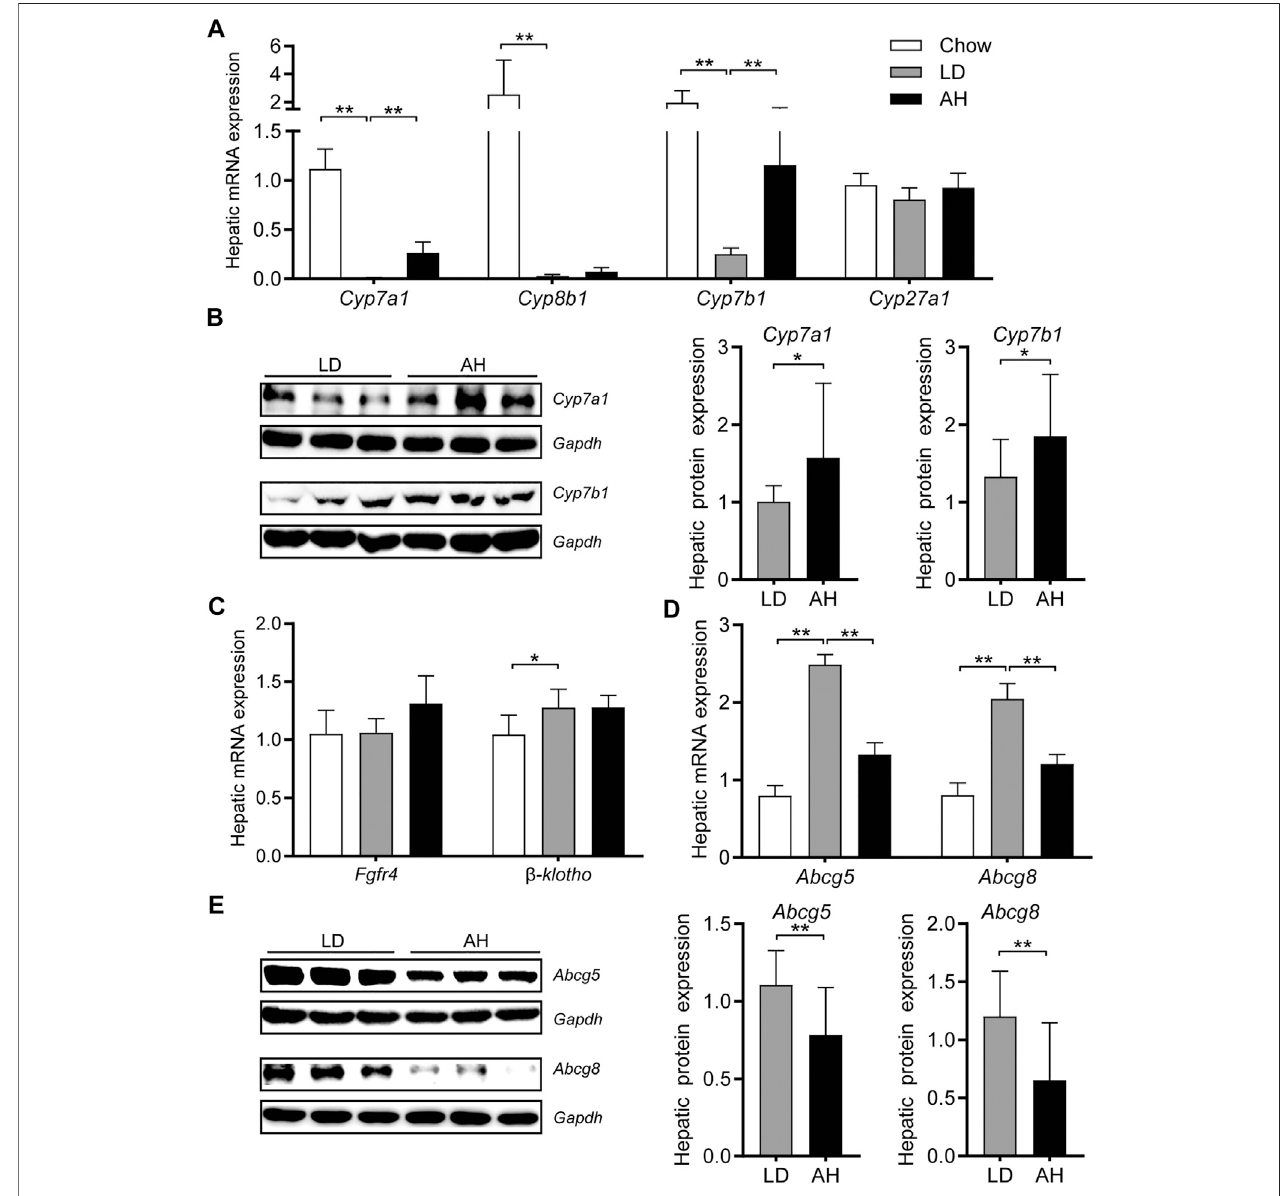
FIGURE 5 | Expression of the genes involved in cholesterol transport and bile-acid synthesis in the liver. (A) mRNA expression of Cyp7a1 , Cyp8b1 , Cyp7b1 , and Cyp27a1 ( n (cid:2) 8). (B) Proteinexpression(leftpanel) andquanti fi cation(middleand rightpanel)of Cyp7a1 and Cyp7b1 ( n (cid:2) 6). (C) mRNAexpressionof Fgfr4 and β -klotho ( n (cid:2) 8). (D) mRNA expressionof Abcg5 and Abcg8 ( n (cid:2) 8). (E) Proteinexpression (leftpanel) andquanti fi cation (middleand rightpanel) of Abcg5 and Abcg8 ( n (cid:2) 6).Data are the mean ± SD. * p < 0.05, ** p < 0.01. Chow, chow diet; LD, lithogenic diet; AH, high-dose APS.